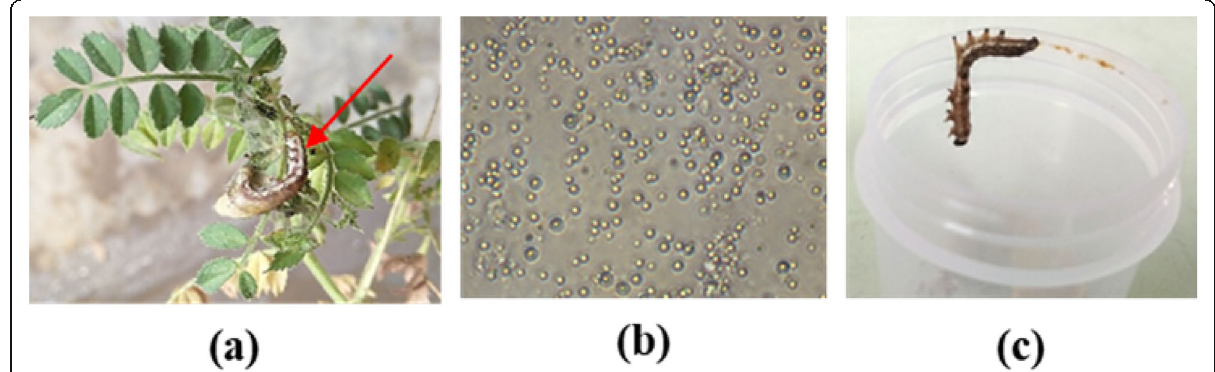
Fig. 1 a Helicoverpa armigera larvae on chickpea showing baculovirus infection. b Phase-contrast image (× 400) of baculovirus OBs. c Virosed larvae of Helicoverpa armigera exhibiting symptoms of nucleopolyhedrovirus (NPV)